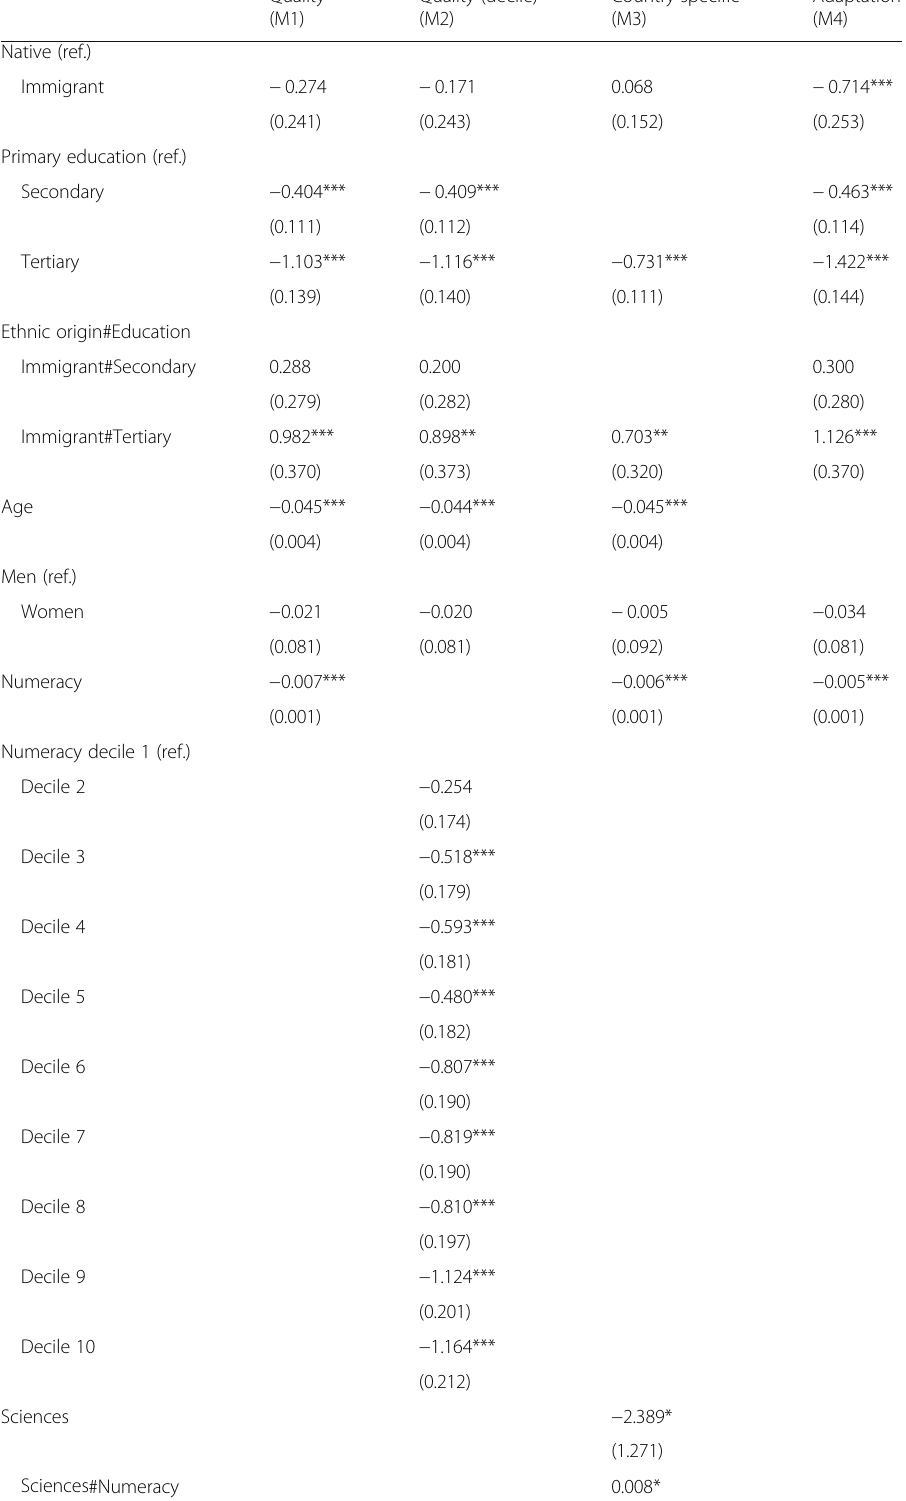
Table 4 Logistic regression on the probability of being unemployed. Explanations for the ethnic gap between natives and immigrants settled in Spain